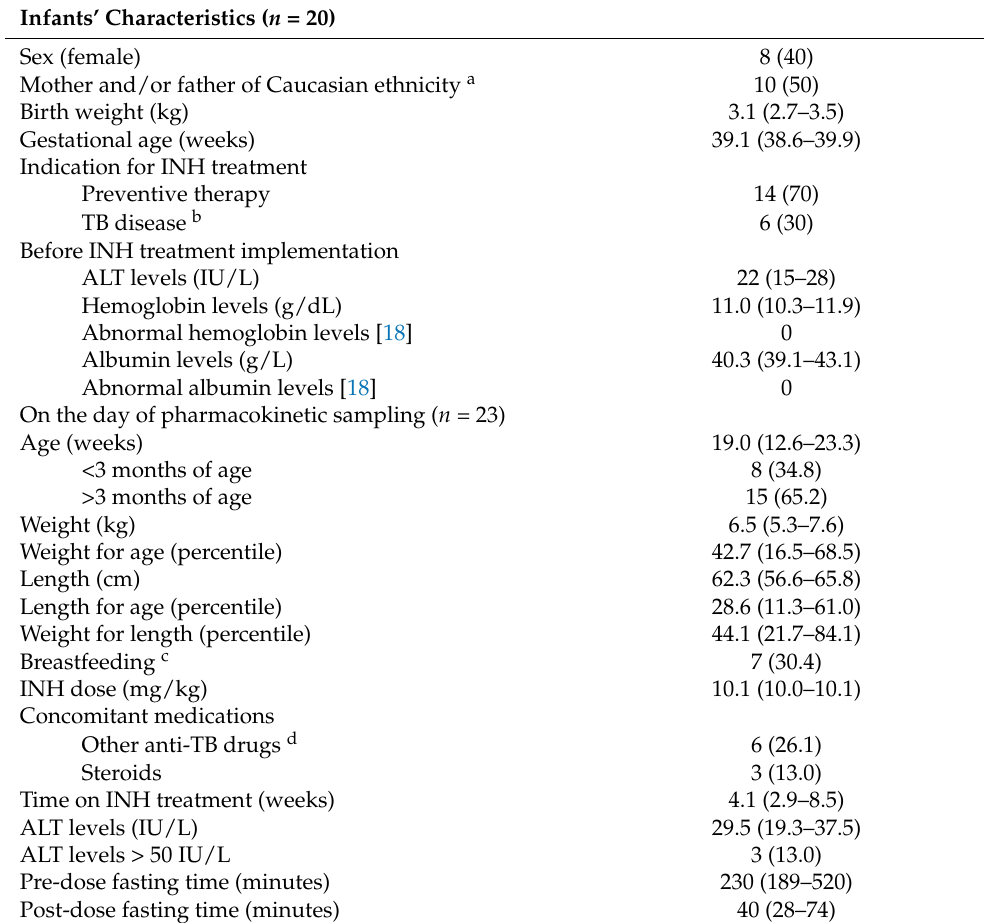
Table 1. Clinical characteristics of the infants ( n = 20) included to assess isoniazid pharmacokinetics at sampling ( n = 23); data are shown either as n (%) or as median (interquartile